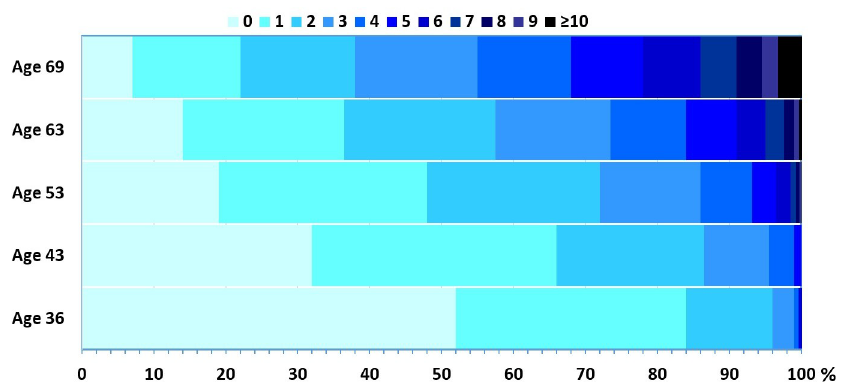
Fig 1. Percentage of participants with increasing levels of multimorbidity (based on 18 common conditions) at each age sweep in 3,723 participants from the 1946 MRC NSHD. NSHD, National Survey of Health and Development.